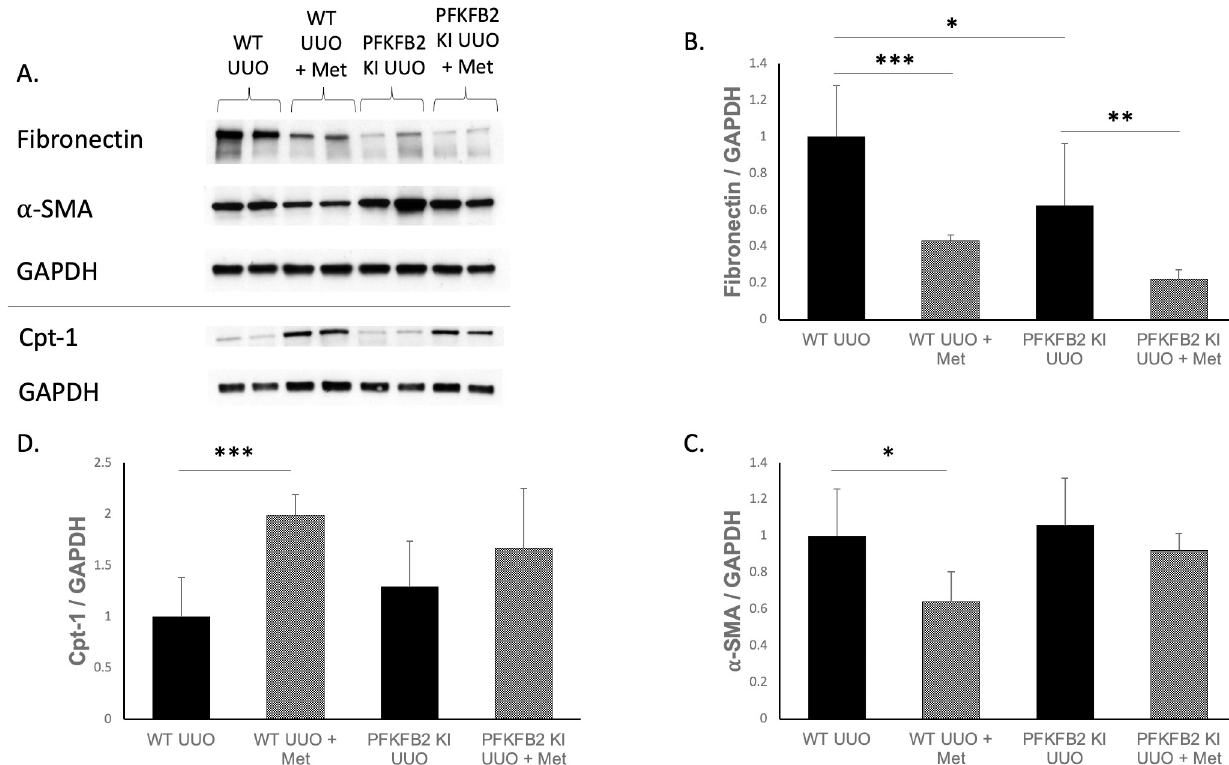
Fig 2. Western blot markers of fibrosis and metabolism following UUO in WT and PFKFB2 KI ± metformin kidneys (A-D). Analysis showed significantly reduced expression of fibronectin and α -SMA in WT UUO metformin kidneys versus controls ( A-C ��� p < 0.001 and � p = 0.01 respectively). PFKFB2 KI UUO controls had reduced fibronectin ( A, B � p = 0.01) but not α -SMA compared to WT ( A, C ). PFKFB2 KI UUO metformin had reduced fibronectin compared to PFKFB2 KI controls ( A, B �� p = 0.009) with a trend towards the same in α -SMA ( A, C ). Expression of Cpt-1 was increased in WT UUO + metformin kidneys compared to WT UUO counterparts ( A, D ��� p = 0.007). Mean +